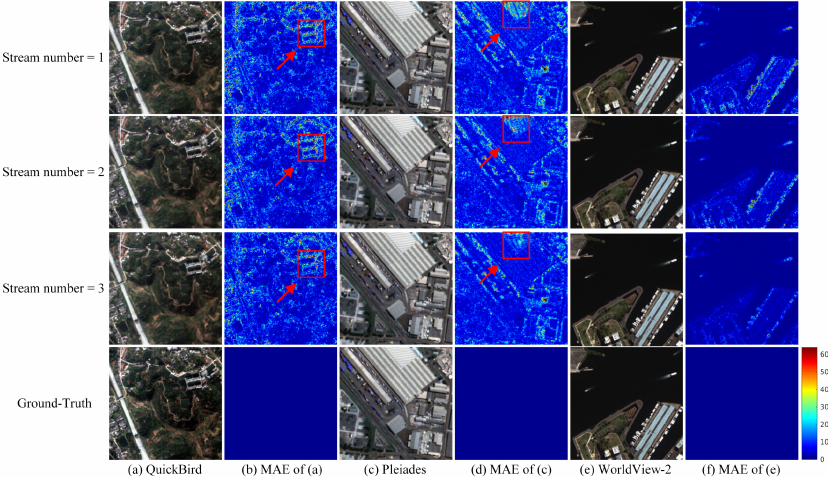
Figure 12. Pansharpening results by using a different number of streams on the three real remote sensing datasets. From top to bottom: fusion results using one, two, and three streams, respec- tively, and the ground-truth images. From left to right: ( a ) QuickBird dataset, ( b ) MAE map of ( a ), ( c ) Pléiades dataset, ( d ) MAE map of (c), (e) WorldView-2 dataset, ( f ) MAE map of ( e